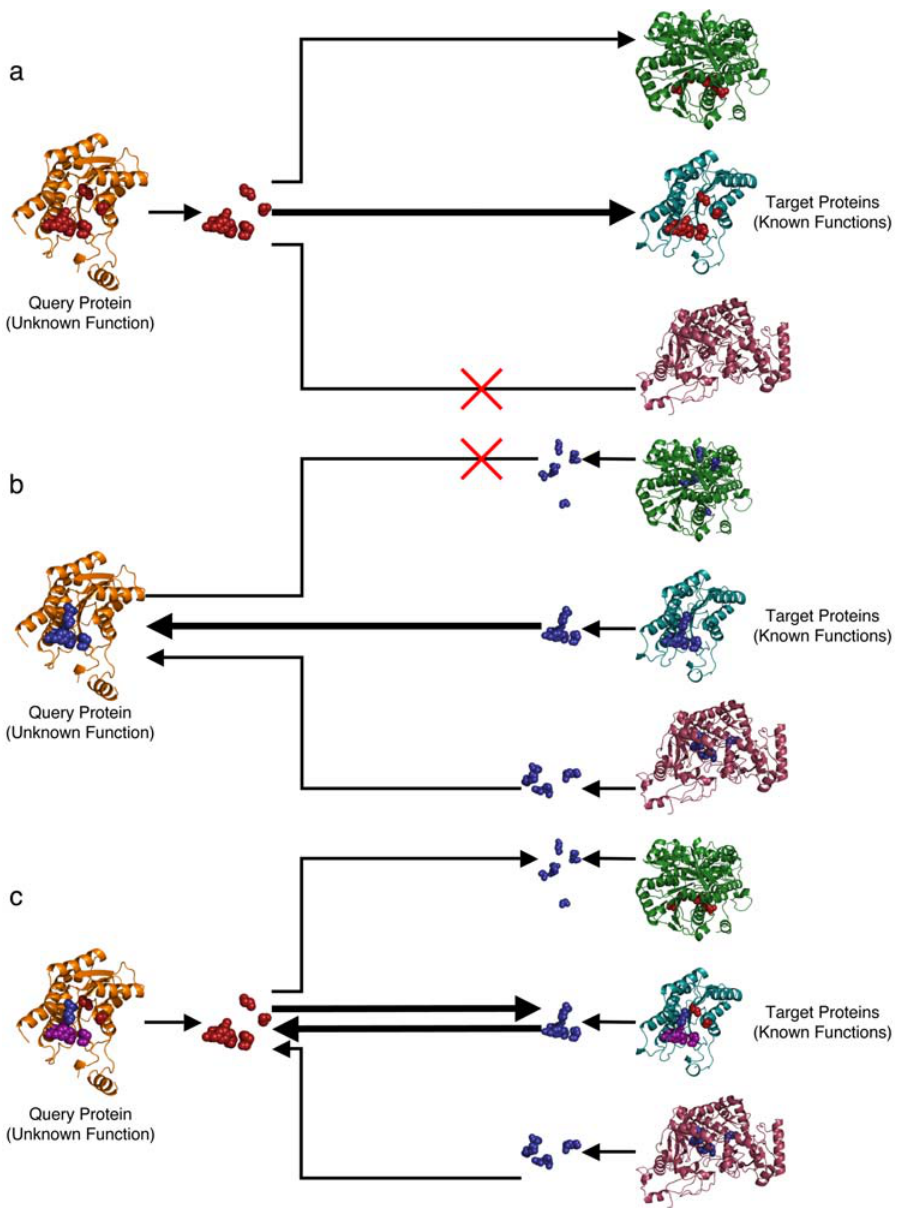
Figure 1. Matching Strategies. Schematic overview of the three matching strategies. 1a, one-to-many matching; 1b, many-to-one matching; 1c, the two superimposed. Lines represent template searches; arrows, matches; bold lines, correct matches; other lines, incorrect matches; X’s, no match. Purple spheres are residues in both the source and target template and match; red spheres, residues in the query template and target match; blue spheres, residues in the target template and query